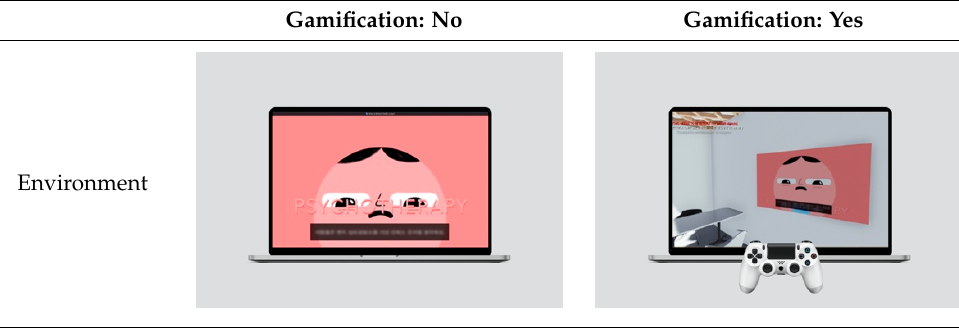
Table 1. The difference between gamification: no and gamification: yes according to environment element.